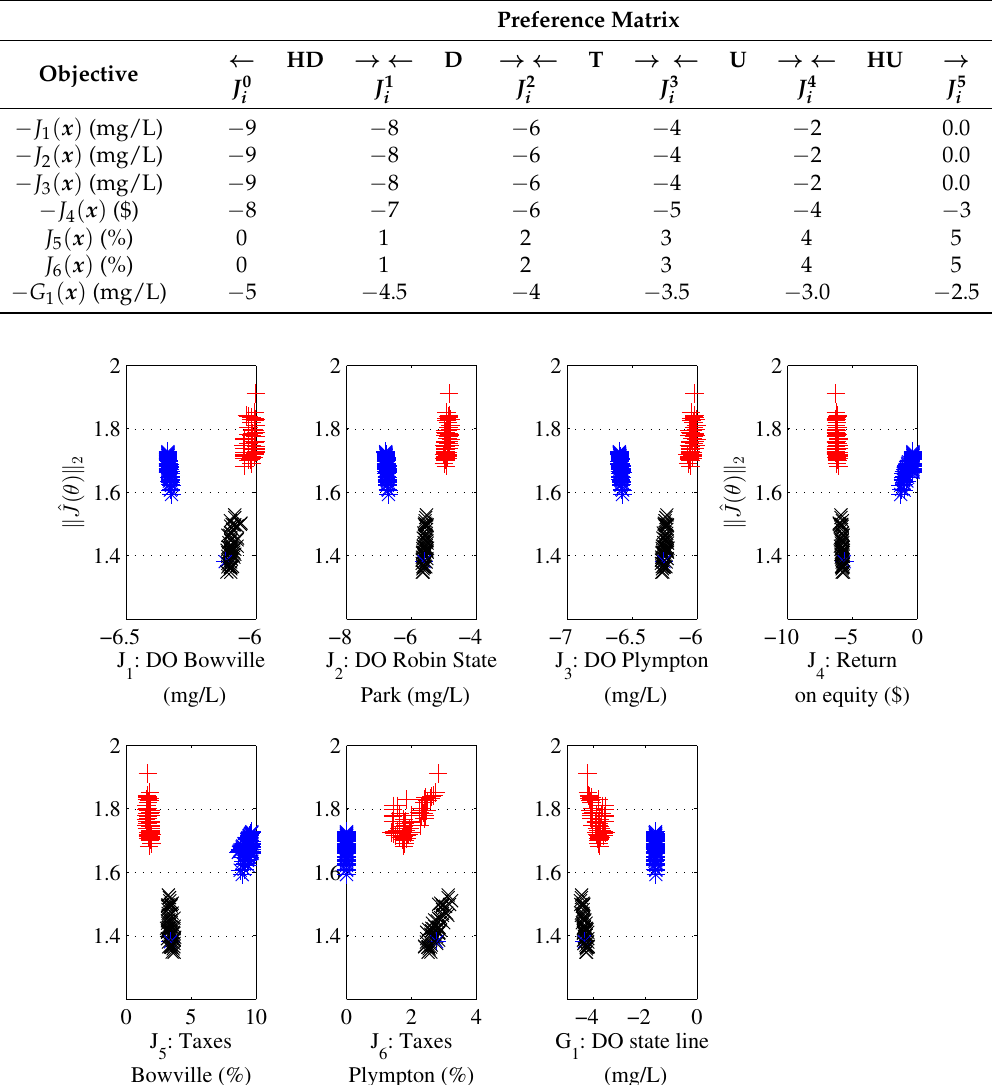
Table 8. Preference matrix m for MOP II statement. Five preference ranges have been defined: highly desirable (HD), desirable (D), tolerable (T) undesirable (U) and highly undesirable (HU).